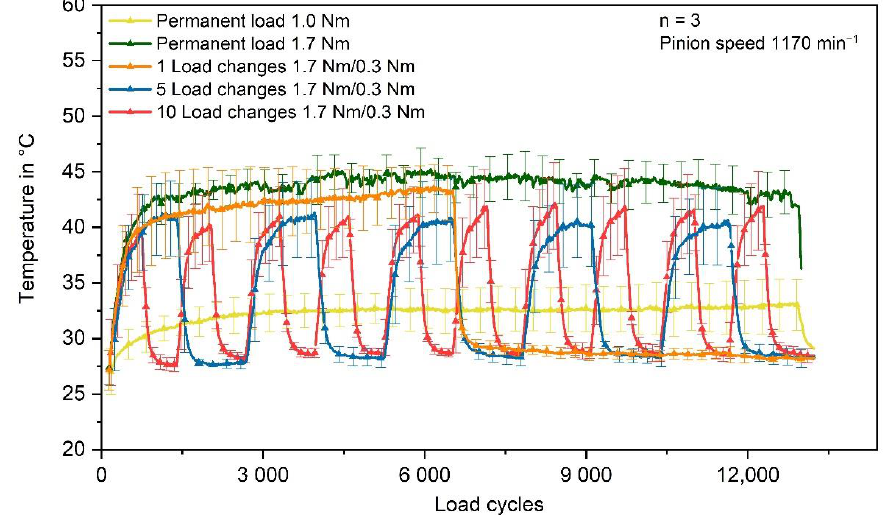
Figure 8. In situ measured tooth root temperature of the polymer gear.